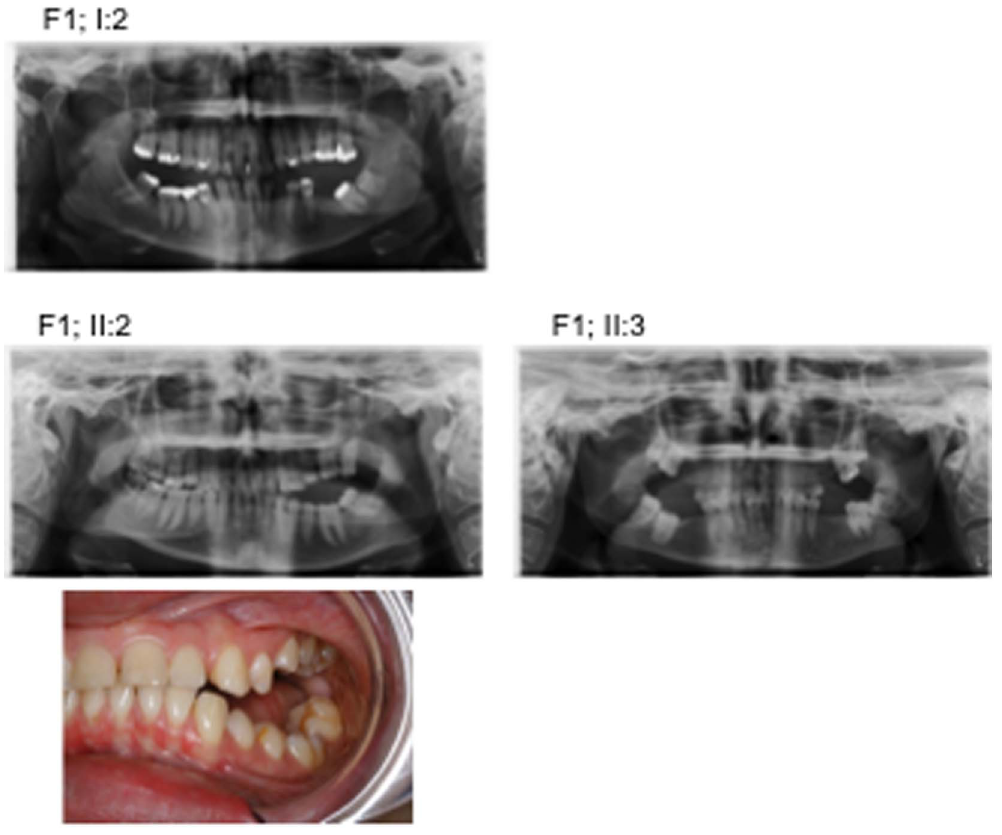
Figure 2. Orthopantomograms of three members from family F1. The pictures illustrate the variable phenotypic expression of the disorder in relation to symmetry and degree of affected teeth. F1; I:2 and F2; II:3 had affected teeth surgically removed, while F1; II:2 also had undergone unsuccessful orthodontic treatment. F1 II,2 is a 20 year old women showing primary failure of eruption (PFE) of maxillary and mandibulary premolars and molars. At age 16 the second molars in the left side of the maxilla and the mandible (27,37) were removed. The following orthodontic treatment was not succesfull. A new treatment plan including distraction osteogenesis of the posterior alveolar segment in the maxilla has been offered to the patient. The treatment has not yet been performed.